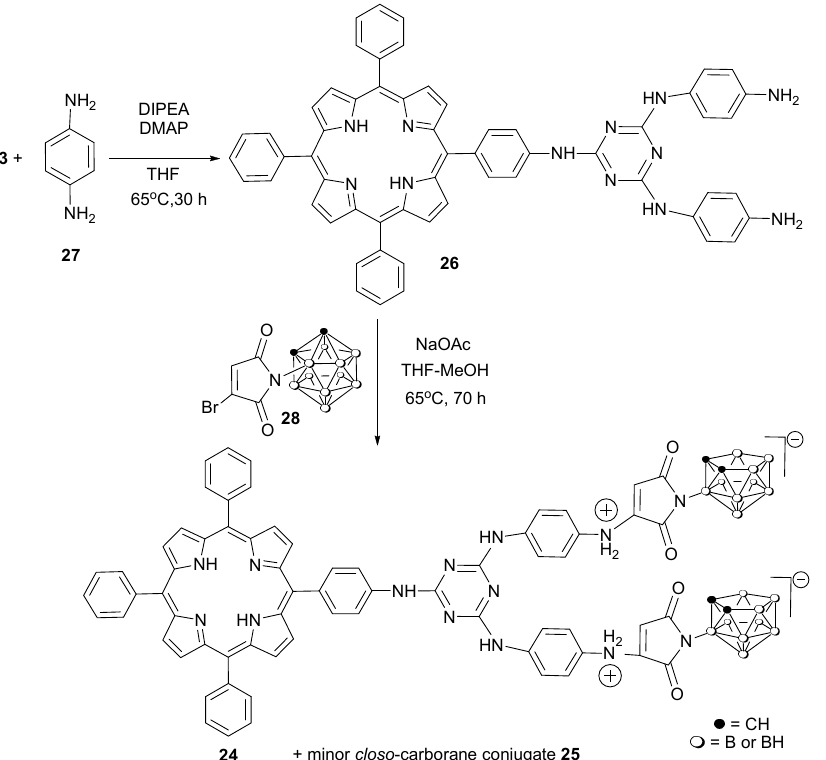
Scheme 7. Synthesis of maleimide-substituted conjugates 24 , 25 .